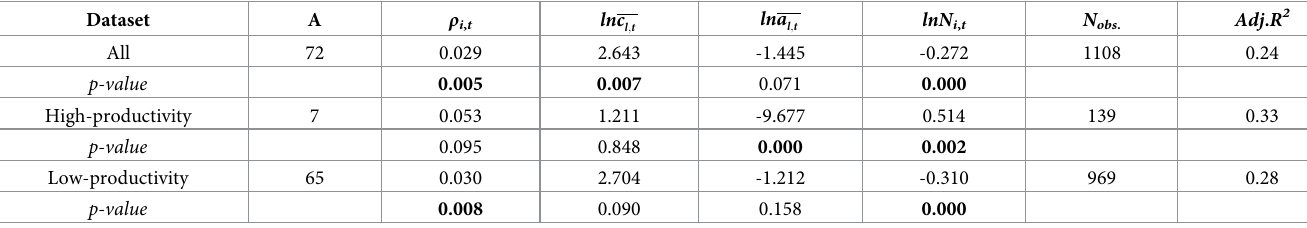
Table 5 lists the (standardized) parameter estimates for Δ t = 1 year. with Δ t = 1 i , t